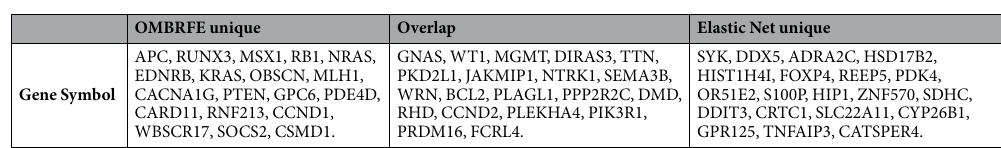
Table 2. The top 20 genes of OMBRFE unique, Elastic Net unique and the overlapping portions of OMBRFE and Elastic